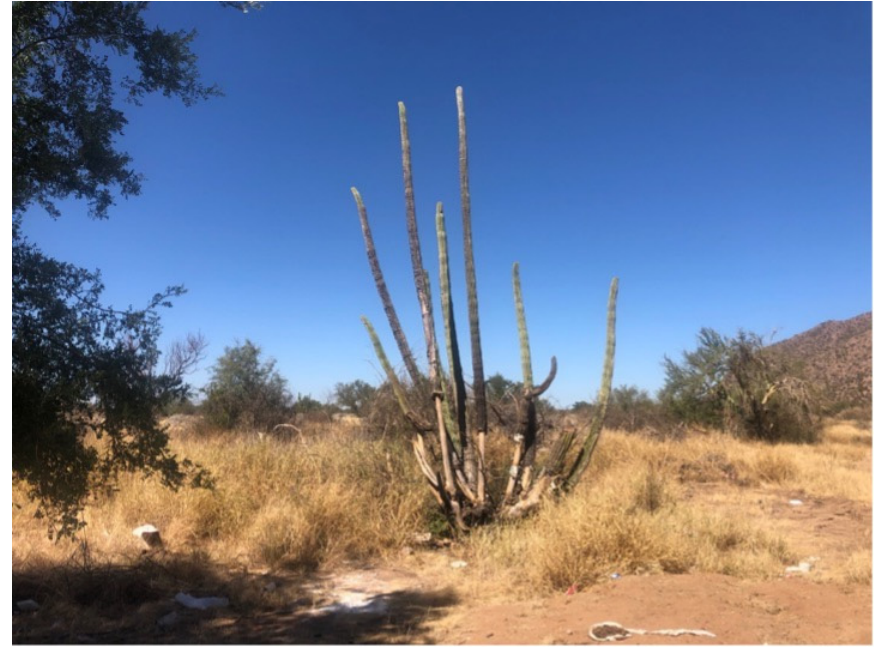
Figure 12. Site contamination and evidence of native vegetation burnout (credit A.